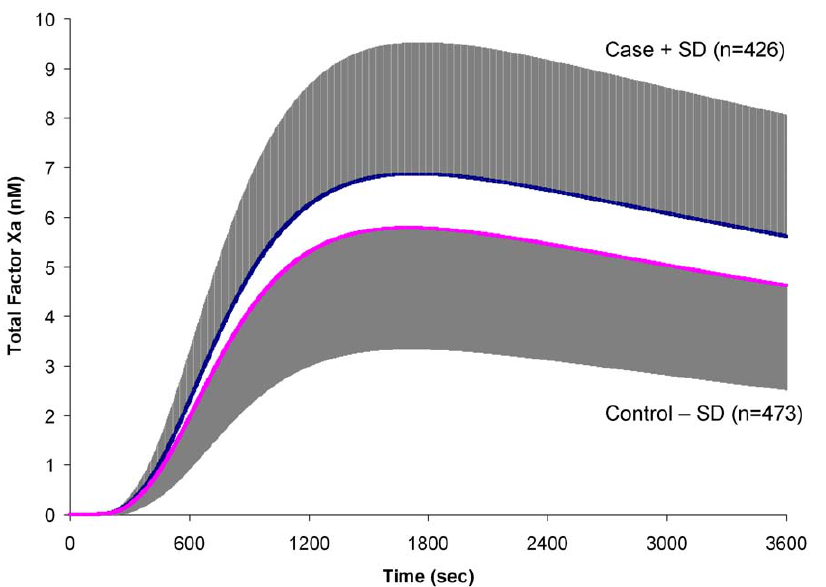
Figure 2. Factor Xa profiles of case and control individuals. Plasma compositions from 473 healthy individuals and 426 individuals with a known DVT were used to generate time courses of total active fXa upon a Tf stimulus of 5 pM. The mean total active fXa level at each second is shown with the standard deviation in grey.